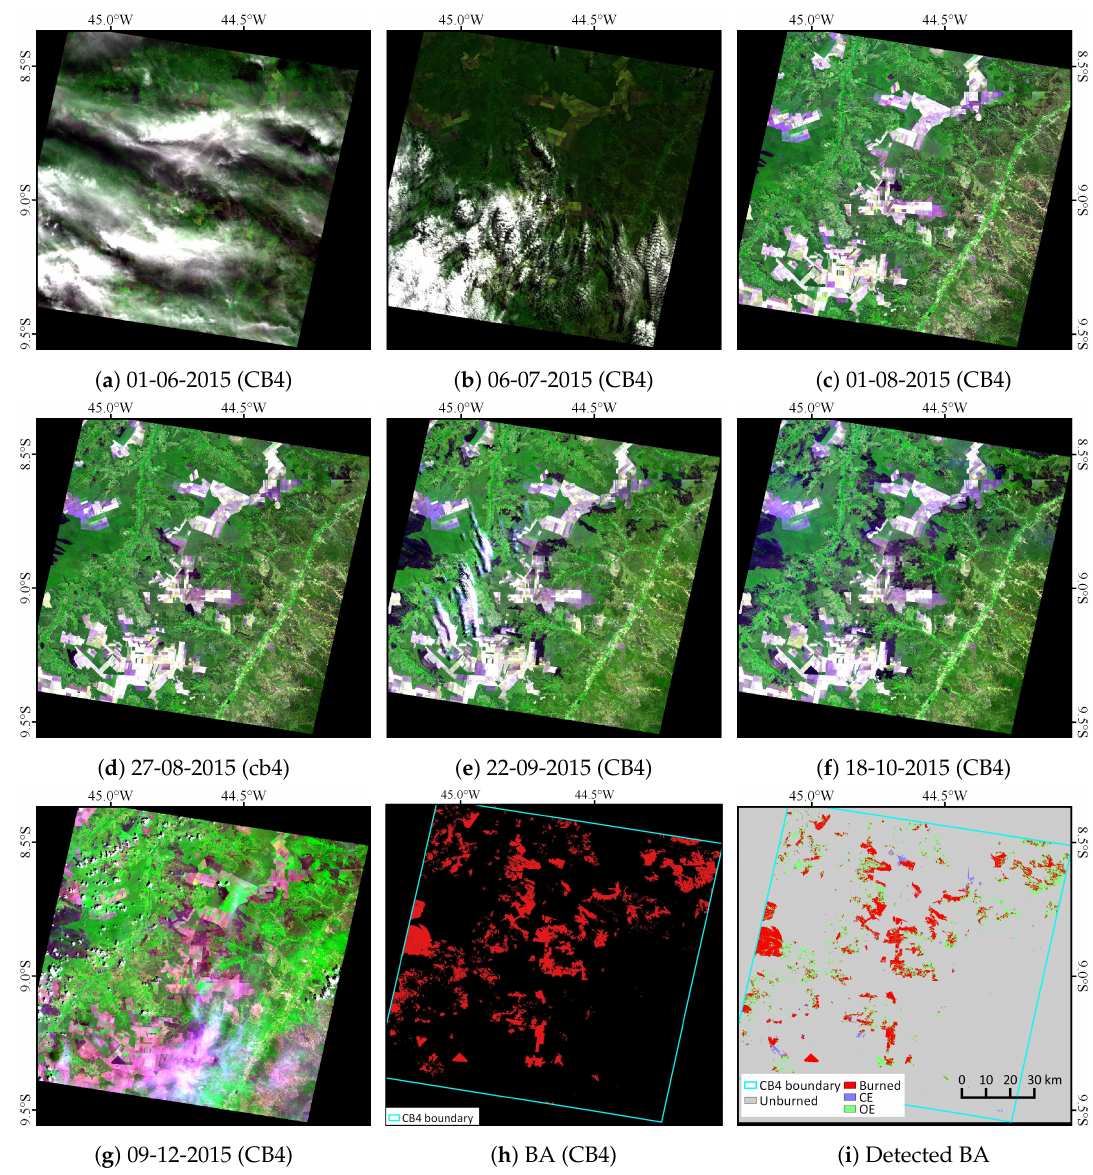
Figure A2. Example of validation using CBERS-4 images. ( a – g ) show the CBERS-4 images used to generate the reference map, displayed in false color composition (red: NIR band, green: red band, and blue: green band); ( h ) is the reference BA map generated from CBERS-4 images; and ( i ) is the detected BA by the proposed method with CE and